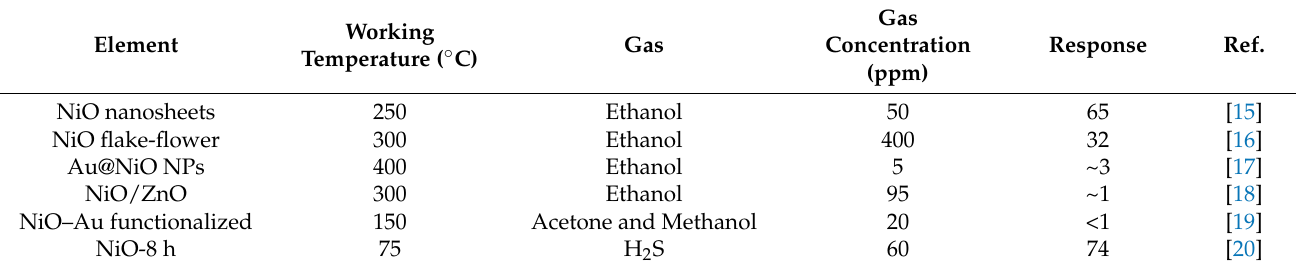
Gas Gas Concentration (ppm)